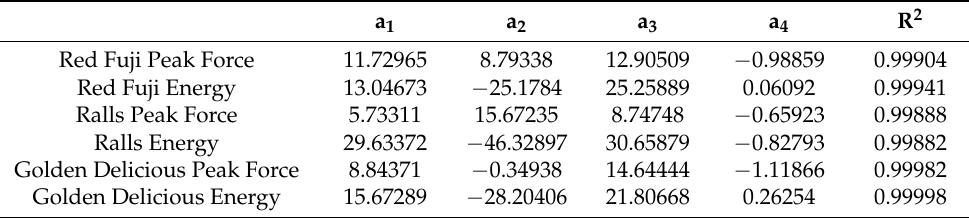
Table 2. Peak force–pressing distance and energy–pressing distance fitting parameters for apples.